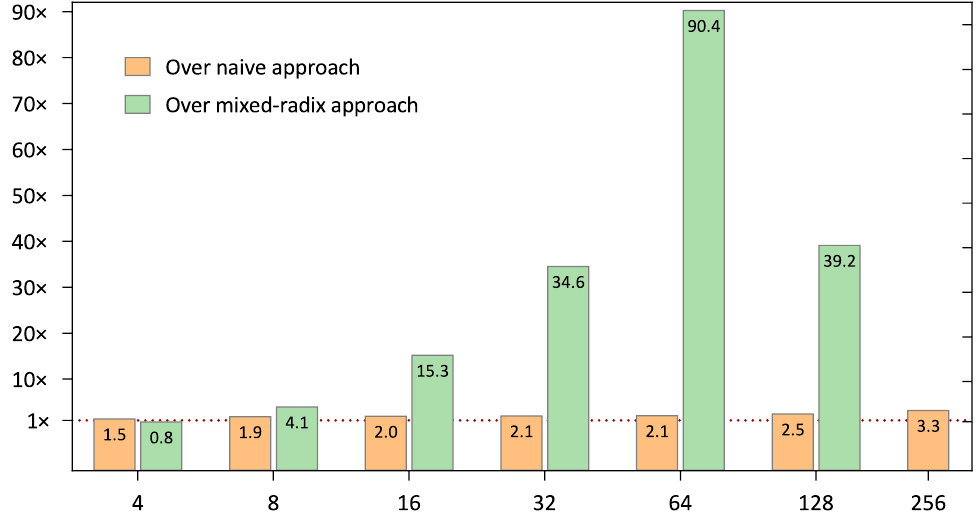
Figure 5. Performance gains of the proposed approach over the other two approaches.